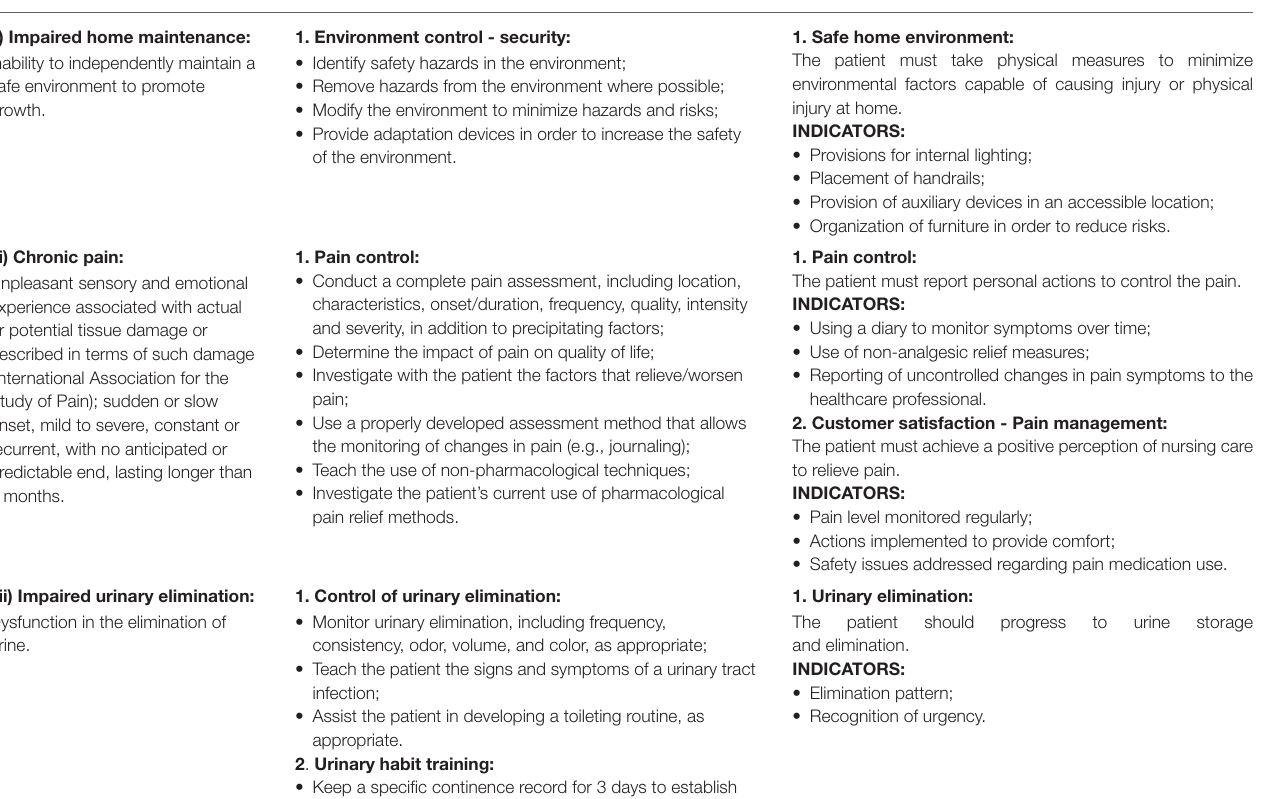
TABLE 2 | Nursing care plans for HTLV-1-infected patients. Nursing diagnoses (NANDA-I) Nursing interventions (NIC) Expected results